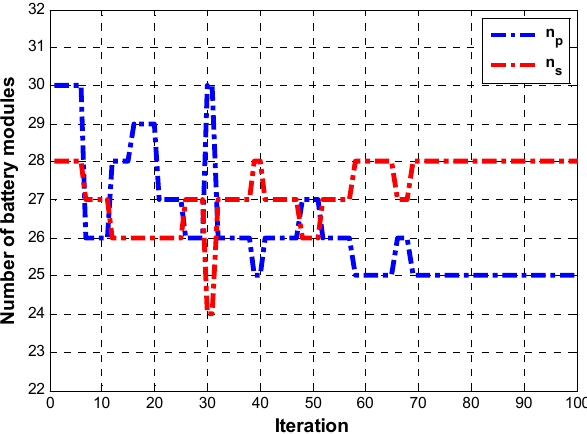
Figure 9. Variation of solutions for the number of modules in optimization Problem 2.